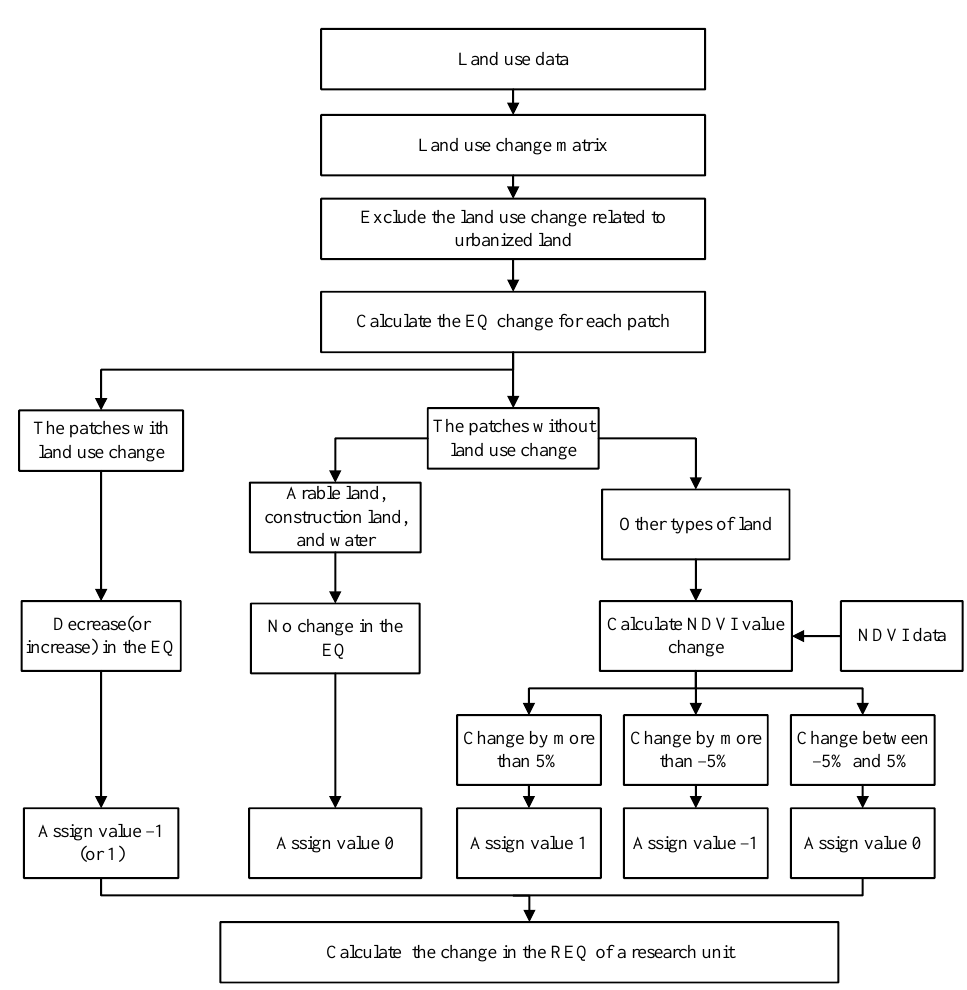
Figure 1. The main steps of measuring the change in the REQ.